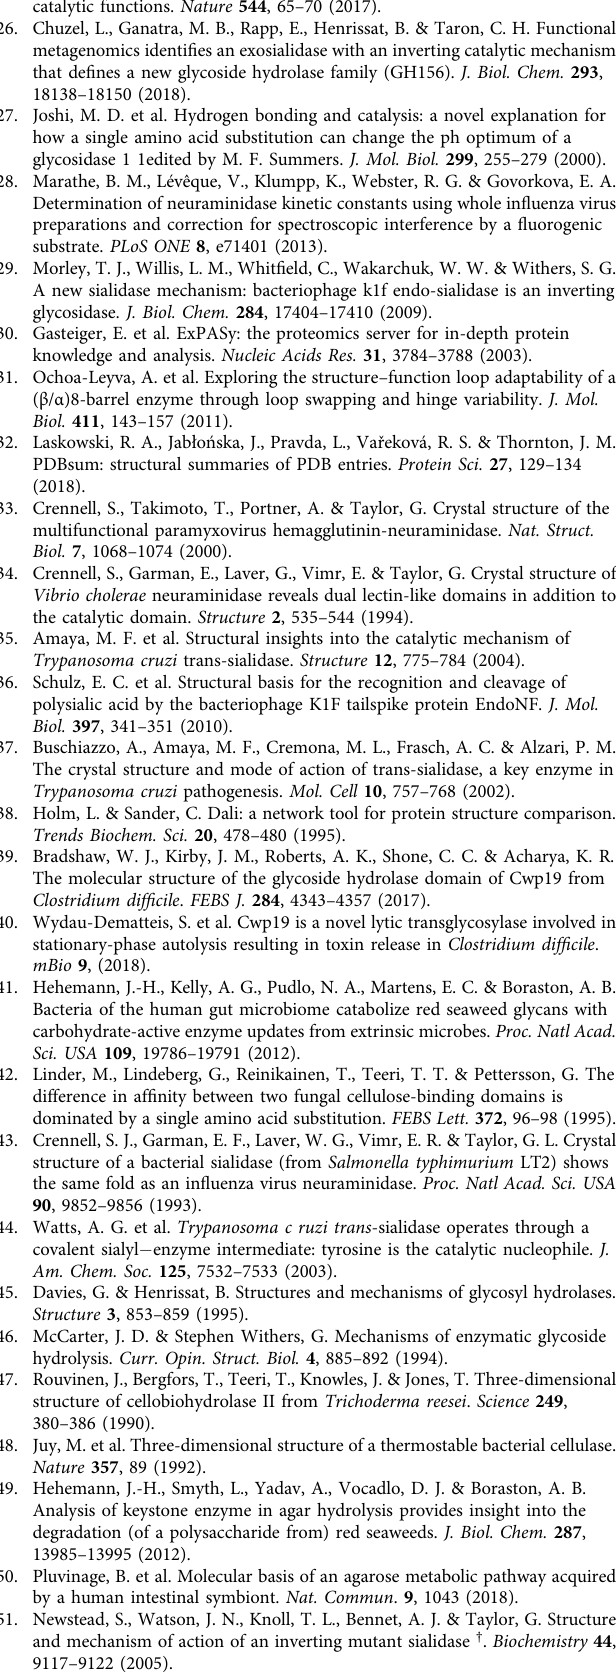
Figs. 1, 4a, 7b and 8 are provided as a Source Data fi le. All further data supporting the fi ndings of this study are available from the corresponding authors, upon reasonable